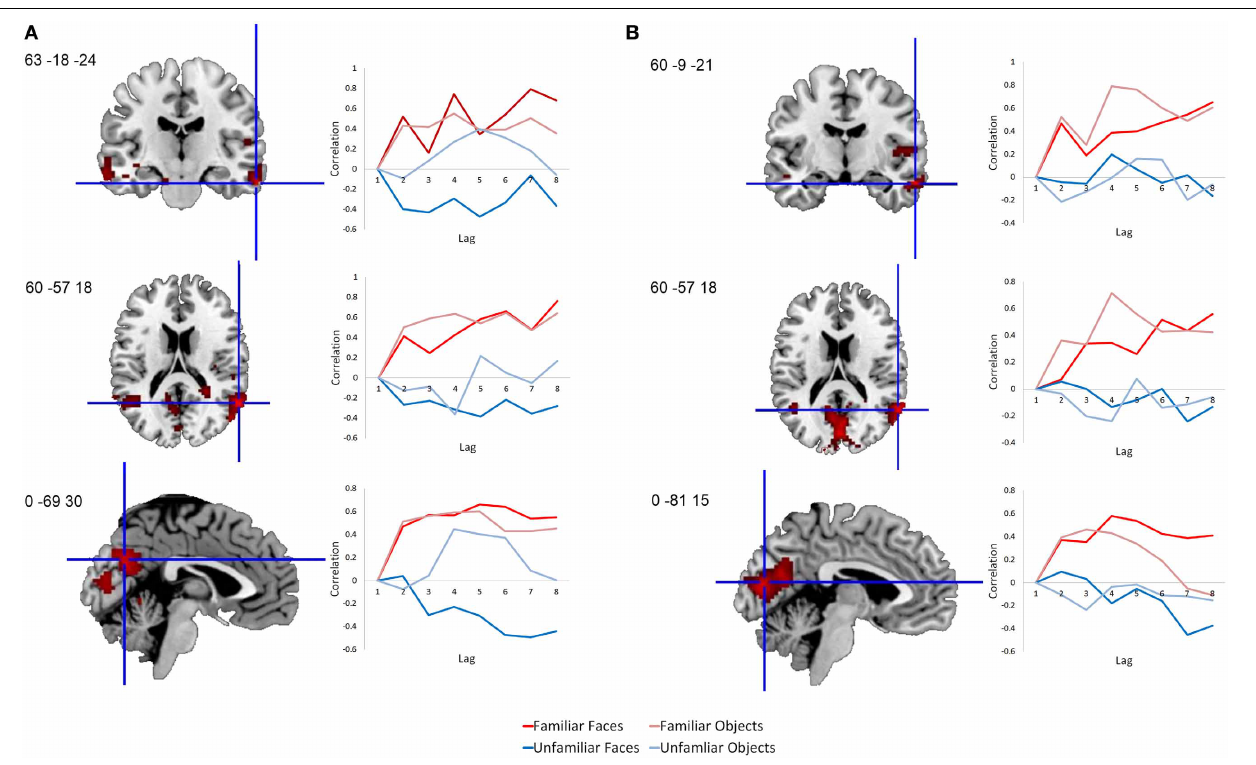
FIGURE 5 | Timecourseofcorrelationsbetweentherightperirhinalcortex and anterior hippocampus and selected functionally-connected regions. Line graphs illustrate the correlations over time following stimulus onset between signal in the seed regions and selected regions within their functionally-connected networks. (A) Correlations are shown between the right perirhinal cortex seed and sample peak regions within its